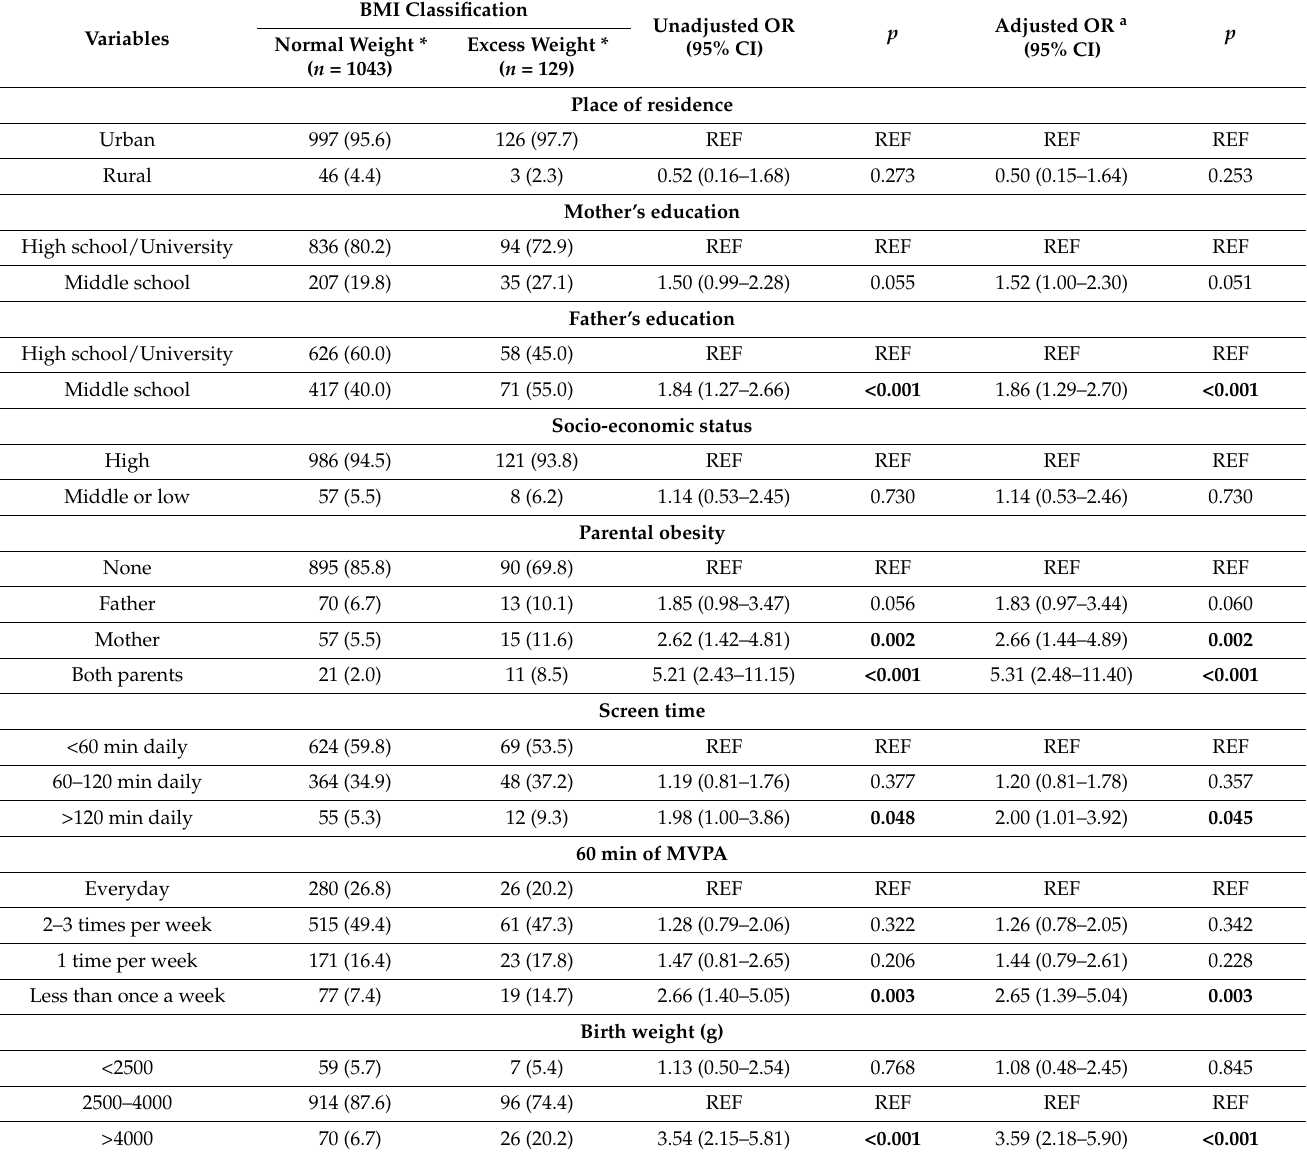
Table 3. Factors associated with excess weight-logistic regression